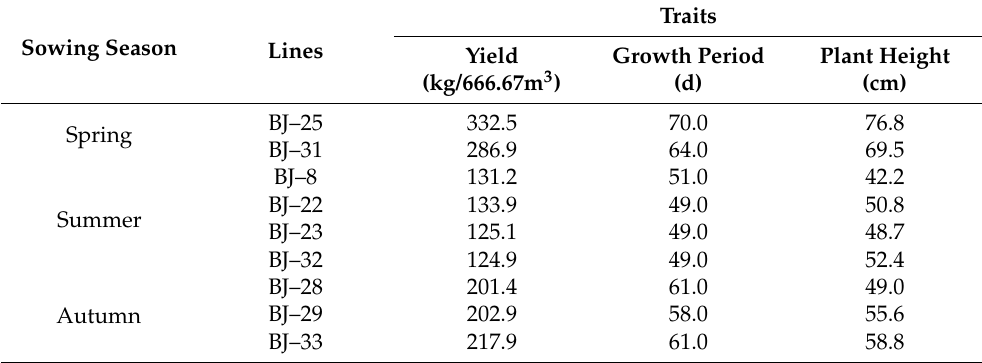
Table 6. Cowpea lines suitable for each sowing season.